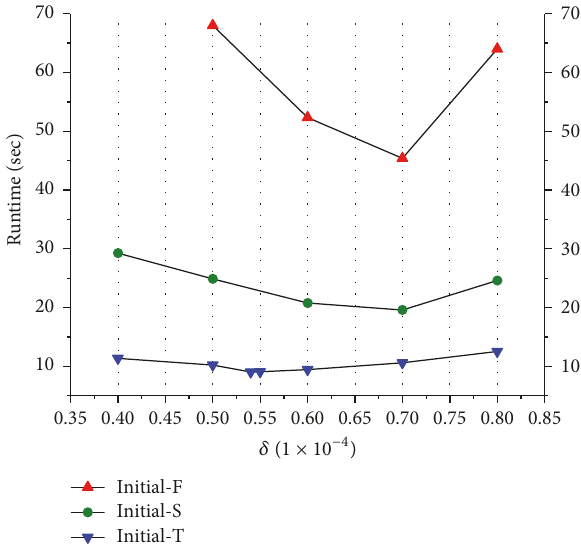
Figure 5: Simulation runtime with different 𝛿 and different method of setting the iterative initial